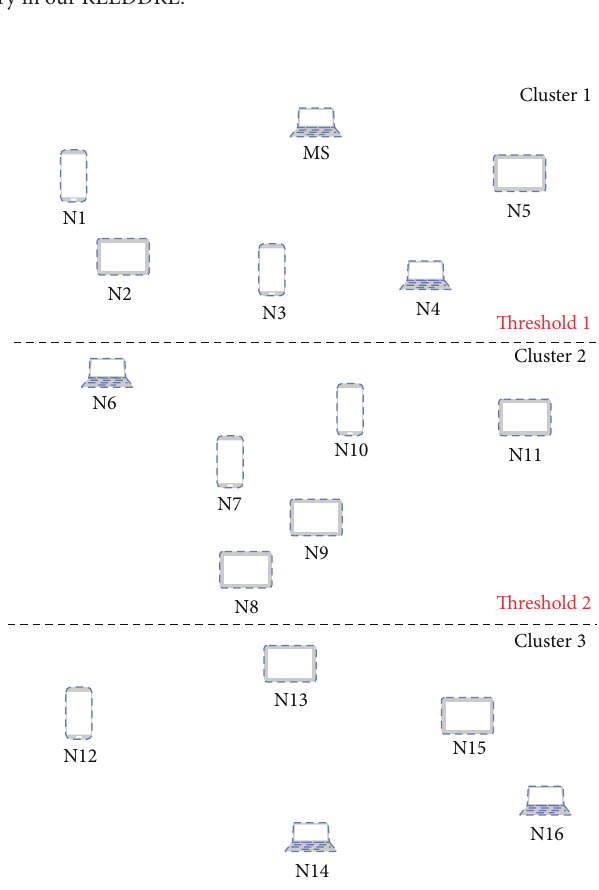
Figure 1: Route discovery in our REEDDRE.